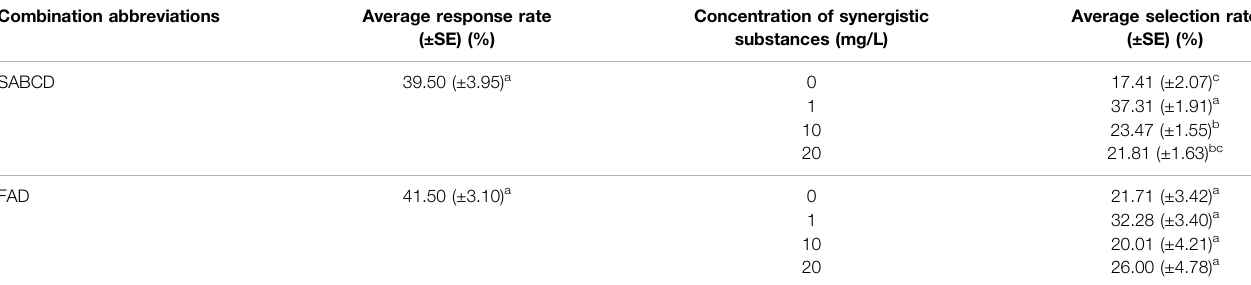
TABLE 4 | The average response rate and selection rate of SABCD and FAD combinations on tobacco beetle adults. Combination